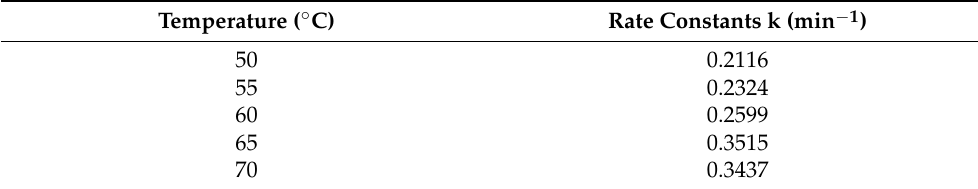
Table 3. Reaction rate constant k versus reaction temperature.